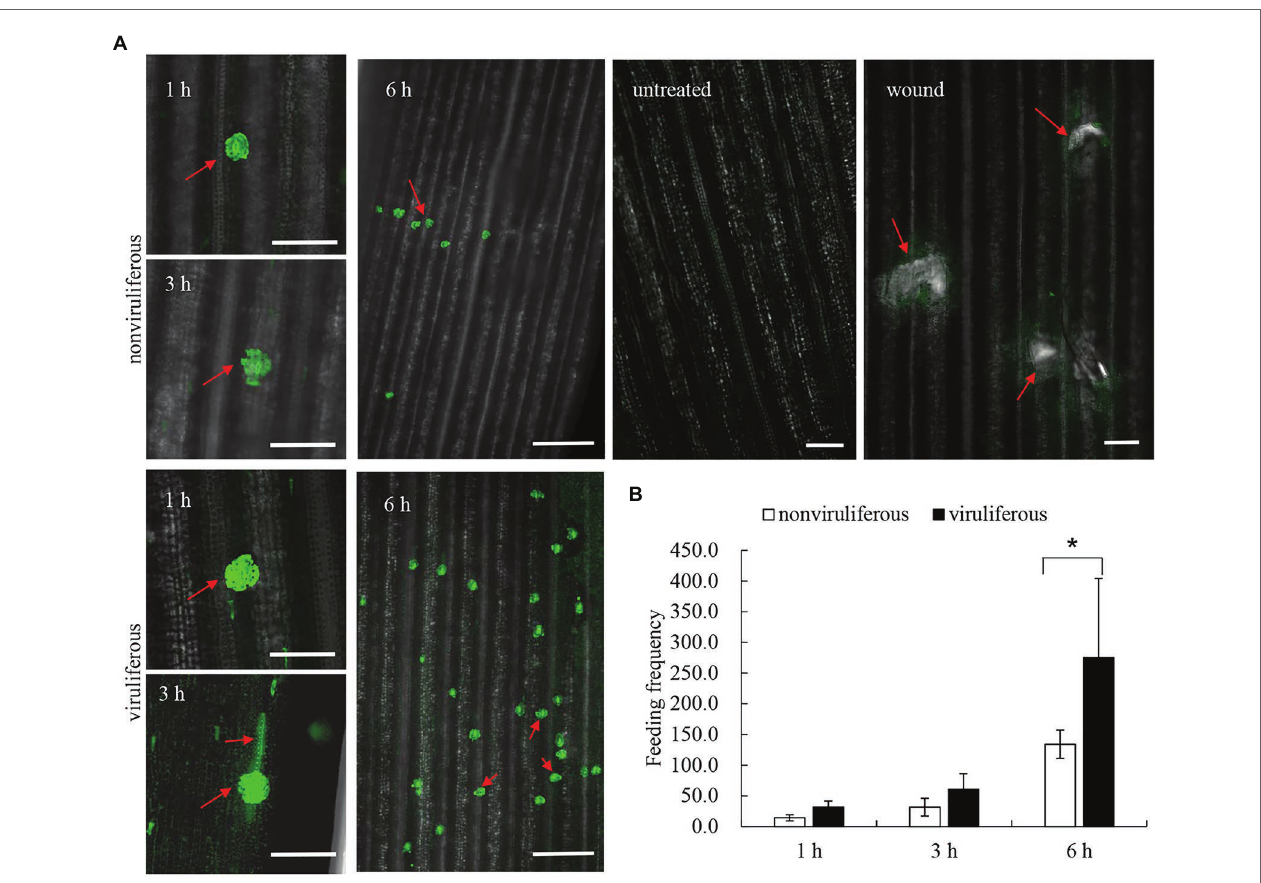
FIGURE 7 | Viruliferous R. dorsalis induced the elevated cytosolic Ca 2+ level in the rice plant. (A) Fluochemical intracellular Ca 2+ determination in leaves infested by viruliferous or nonviruliferous adults of R. dorsalis . The green fluorescence refers to the binding of Fluo-3 AM with Ca 2+ . A portion of rice leaf incubated with 5 μ M Fluo-3 AM solution was infested by viruliferous or nonviruliferous adults for 1, 3, and 6 h. The sample without insect infestation served as the control. Untreated and wound-treated rice plants were used as controls. Scale bars: 100 μ m. Arrows indicated the feeding sites. (B) Statistical analysis of feeding sites in infested-leaves by viruliferous and nonviruliferous adults. Significant differences of feeding sites were indicated with *( p , 0.05); student’s t